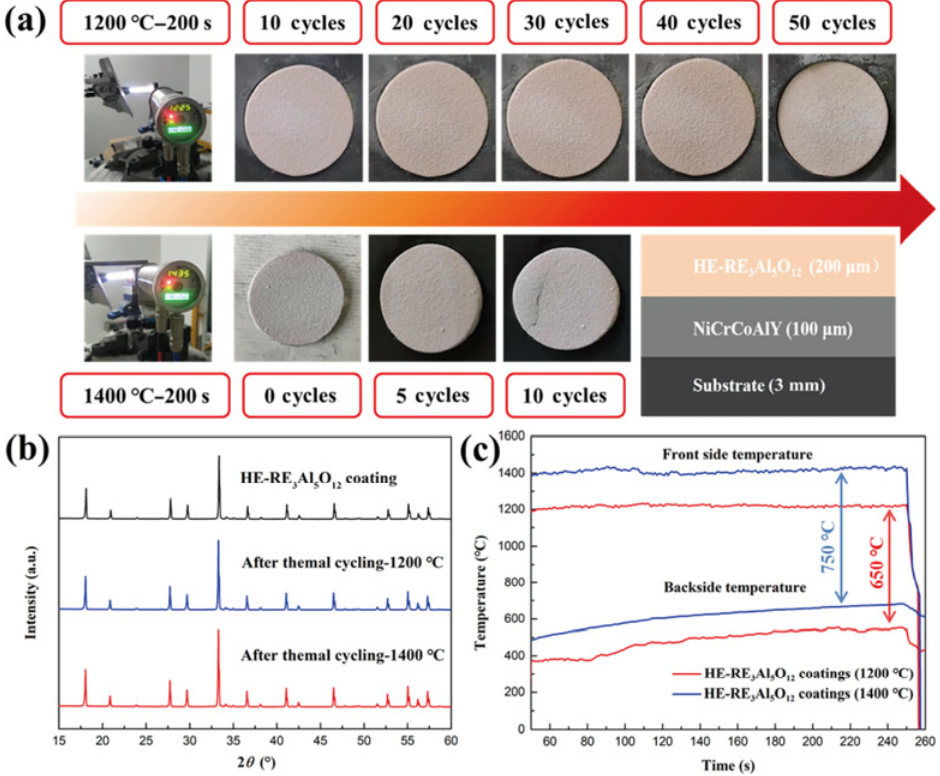
Fig. 8 (a) Digital camera images of the selected thermally cycled samples after different cycles at 1200 ℃ for 200 s and 1400 ℃ for 200 s. (b) XRD patterns of the HE-RE 3 Al 5 O 12 coating before and after the thermal cycling test. (c) Temperature profiles of HE-RE 3 Al 5 O 12 coating samples over a complete thermal shock